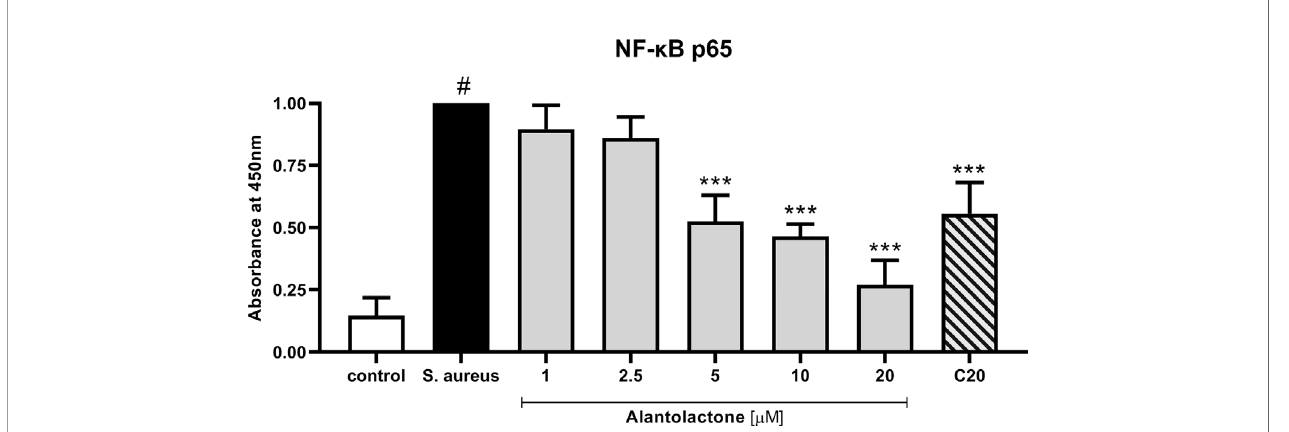
FIGURE 9 | The in fl uence of alantolactone on p65 NF- k B concentration after S. aureus infection. Statistical signi fi cance: *p < 0.05, **p < 0.01, ***p < 0.001 versus stimulated control (ANOVA and Dunnett ’ s post hoc test); control — non-stimulated control; S. aureus — S. aureus -stimulated control. # statistically signi fi cant (p < 0.001) versus non-stimulated control.